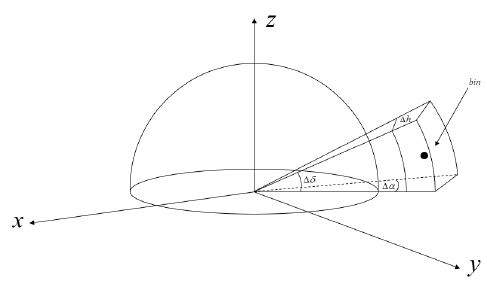
Figure 3. The spatial pattern of the bin.